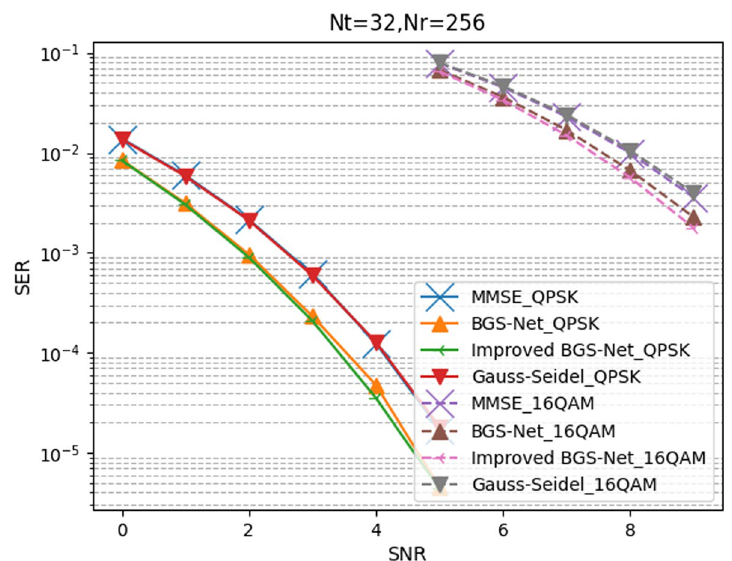
Fig. 23 Effect of different modulation orders on SER performance for N t = 32,N r = 256 , MAUE system with ξ r = 0, ξ t = 0.2